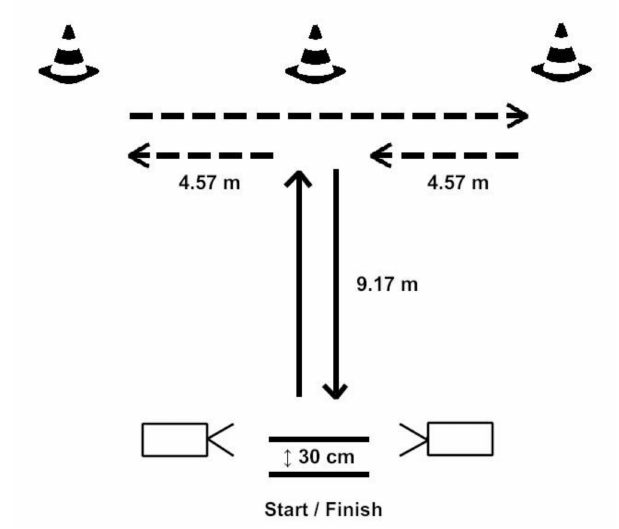
Figure 2. Schematic representation of the